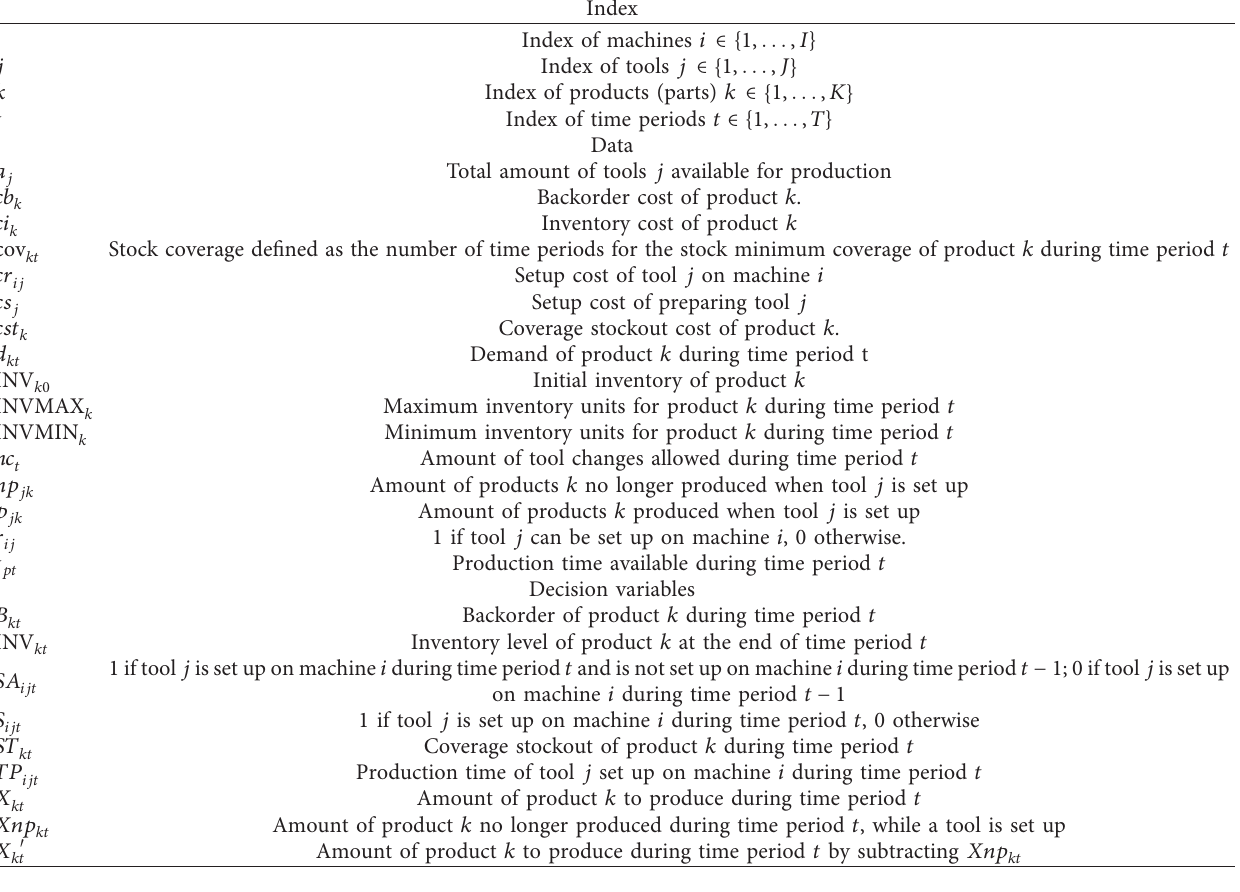
Table 2: Nomenclature for the